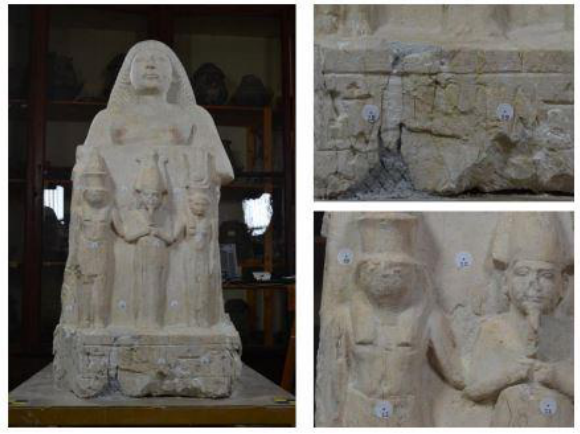
Figure 1. Front of the statue and details of the points of application of US probes (28 and 29 in the lower portion of the crankcase and 19, 20, 22 and 23 in the upper portion).